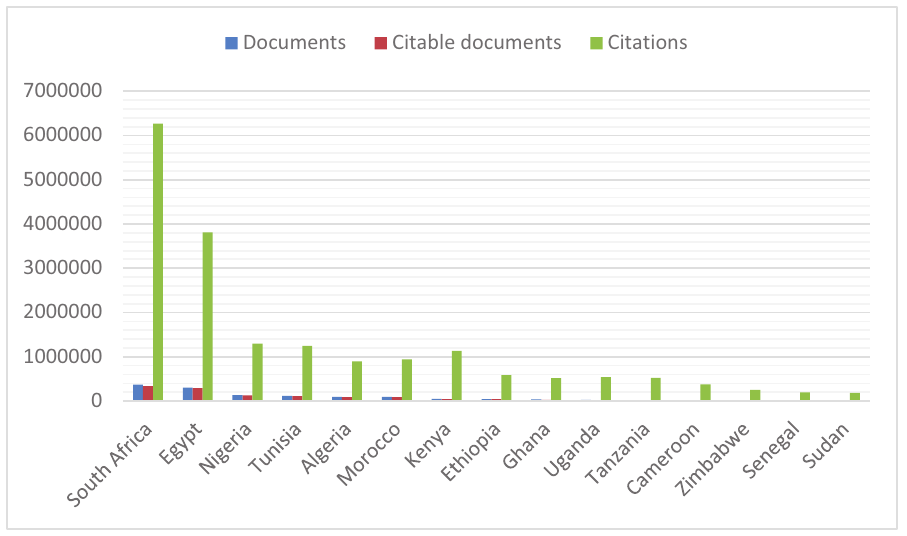
Figure 1 : Number of documents, citable documents, and citations published in 1996–2021 by the first fifteen African countries (based on Scopus data as of April 2022).